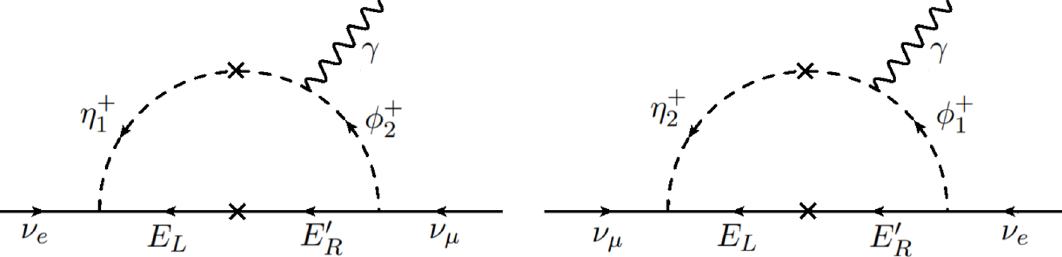
Figure 15 . Feynman diagrams generating neutrino transition magnetic moment (cid:22) (cid:23) SU(3) H model. The same diagrams with the photon lines removed could contribute to neutrino mass, but the diagrams cancel in this